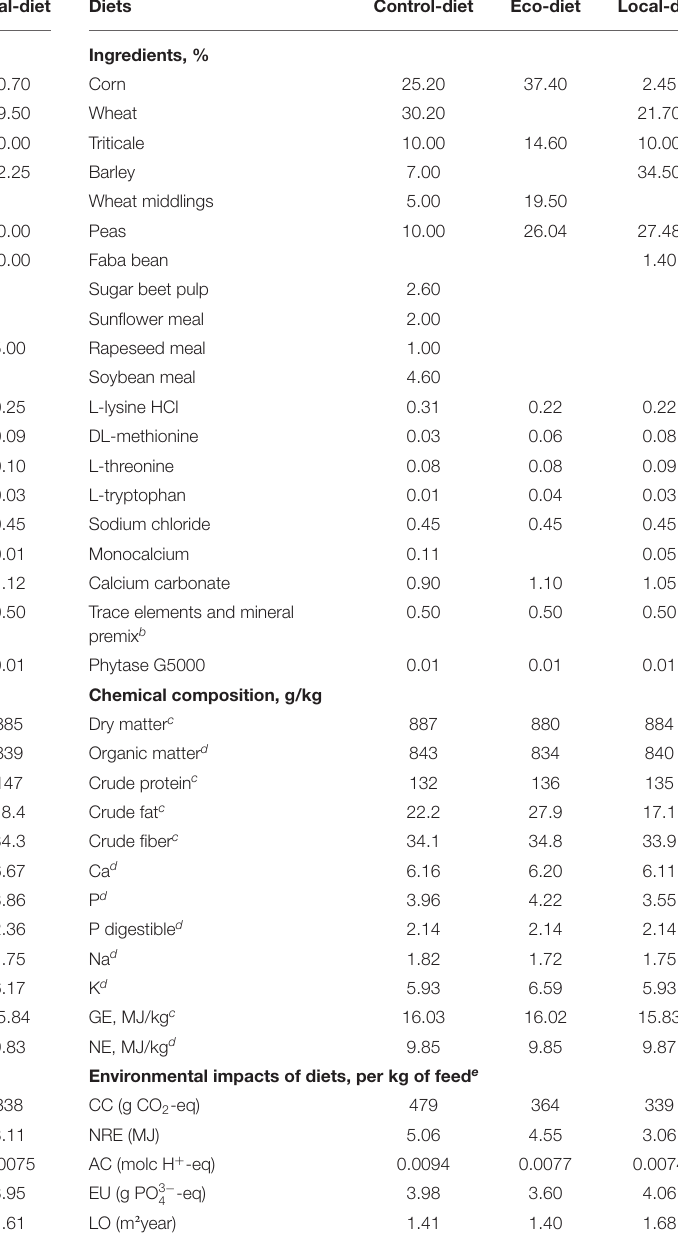
TABLE 1 | Composition of experimental growing diets a . TABLE 2 | Composition of experimental finishing diets a